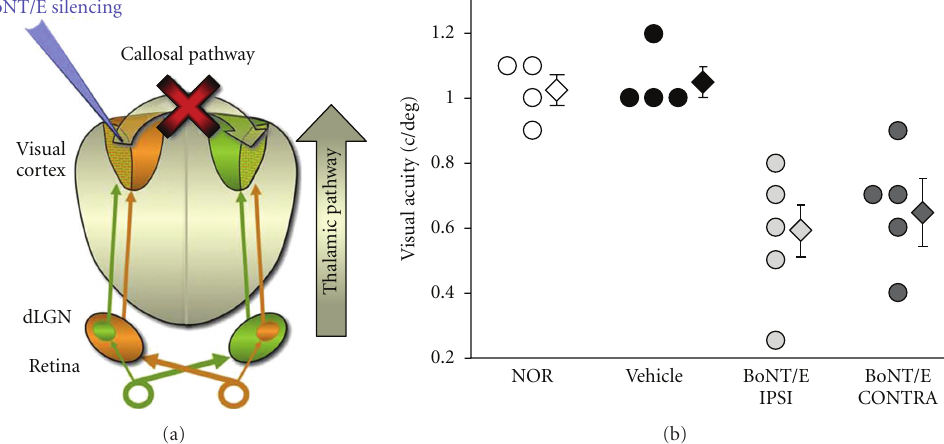
Figure 1: Silencing callosal input during the early critical period impairs maturation of visual acuity. (a) Schematics of the experimental protocol. BoNT/E was unilaterally injected into the visual cortex in P14 rat pups to cause a prolonged silencing of one hemisphere. The contralateral, uninjected side has a normal visual experience through the retinogeniculate pathway and only lacks callosal input activity. (b) Bilateral impairments in visual acuity at P35 after unilateral injection of BoNT/E at P14: summary of visual acuities in na¨ıve rats (NOR), rats injected with vehicle (VEHICLE) and in the hemisphere ipsilateral (IPSI) and contralateral (CONTRA) to BoNT/E infusion. Each circle represents one animal. Mean visual acuity (diamonds) is significantly reduced in both hemispheres of BoNT/E rats in comparison with that in normal or vehicle-injected animals. Error bars indicate SE. Data are from